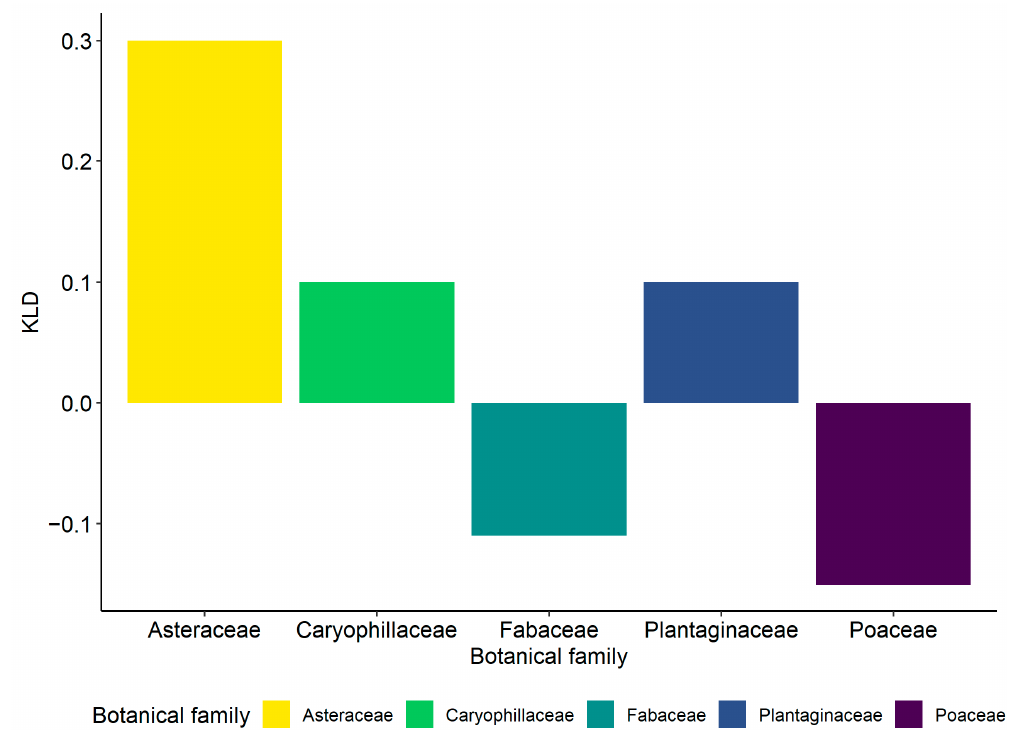
Figure 6. Relative distribution (percentages) of the nymphal instars of Philaenus spumarius on each host plant genus. The 10 host plant genera in vineyard hosting the highest number of spittlebug nymphs are shown. Numbers beside bars represent the total number of nymphs sampled on each genus by year of survey: 2016 ( left ) and 2017 ( right ).